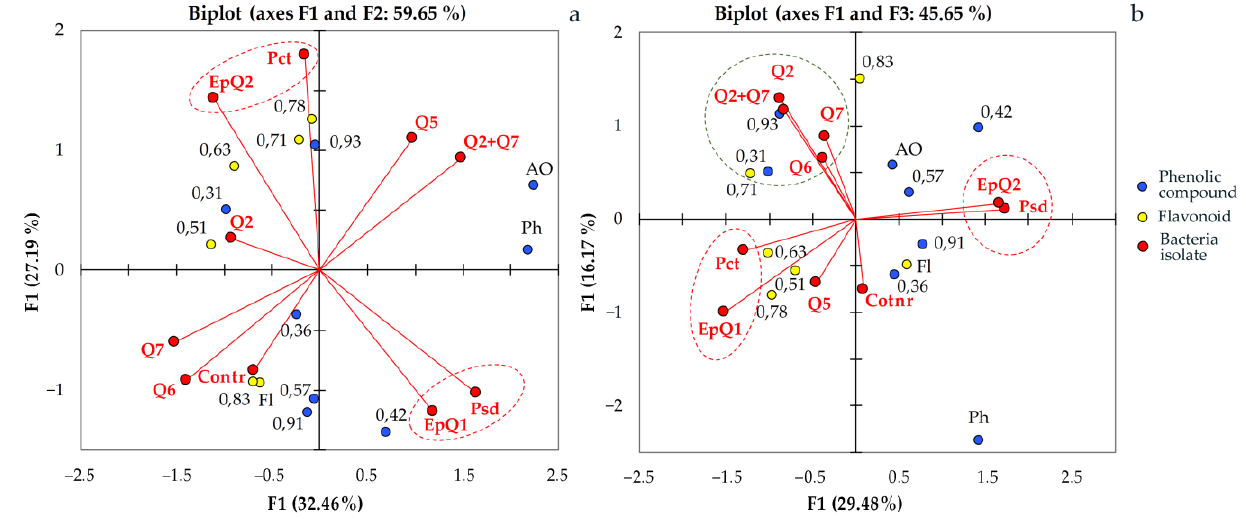
Figure 6. Principle component analysis by phytochemical profiles of phenolic compounds in common oak leaves after their treatment with endophytic bacteria .